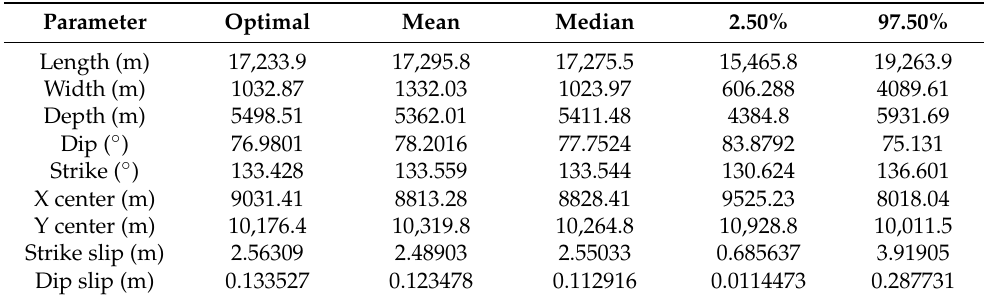
Table 2. Seismic fault geometric parameters of the 2021 Yangbi M W 6.1